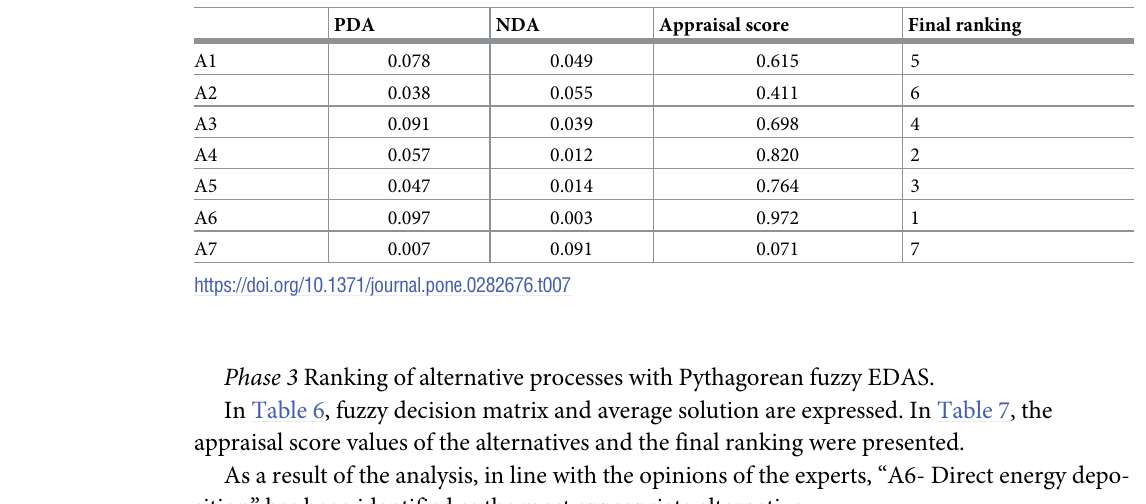
Table 7. PDA, NDA, appraisal score and final ranking of